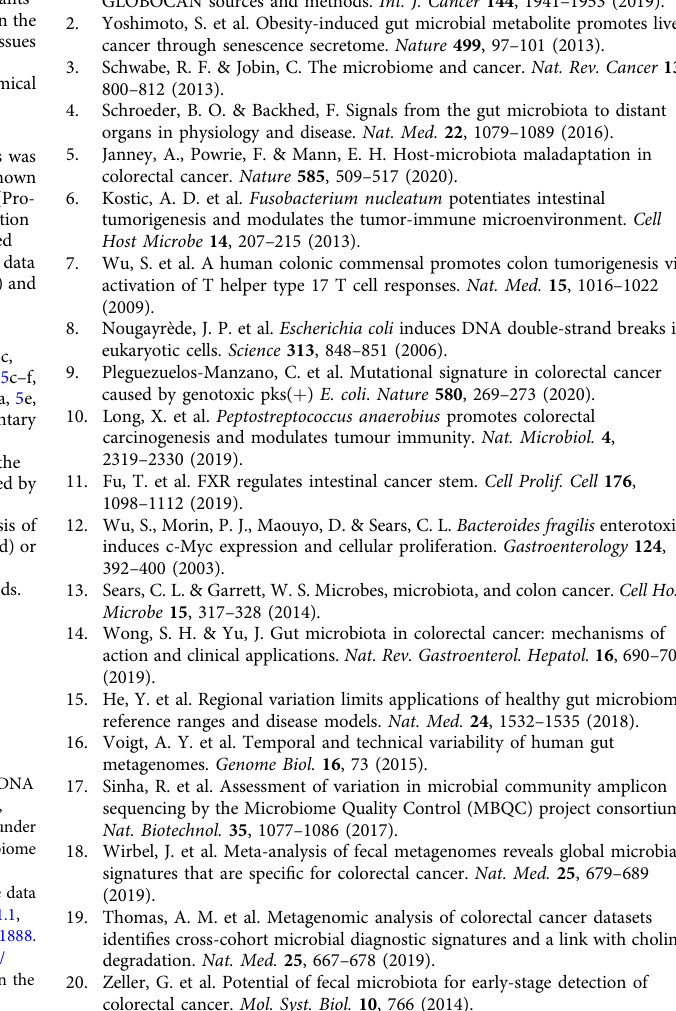
Fig. 5 Bacterial invasion and tumour promotion. a Clinical information on surgically resected CRC tissues and relative abundances of OTUs corresponding to the two bacterial species ( P. asaccharolytica and P. gingivalis ) in the faeces of the patients analysed. b Paraf fi n-embedded CRC tissues were subjected to the in situ hybridization using probes speci fi c to P. asaccharolytica , or P. gingivalis , or to the immuno-staining analysis using indicated antibodies. These assays were performed in three biologically independent replicates to show representative data. c Butyrate concentrations in CRC tissues and paired non- tumour tissues of eight patients. Statistical signi fi cance was determined with a two-tailed Wilcoxon signed-rank test. P value < 0.05 was